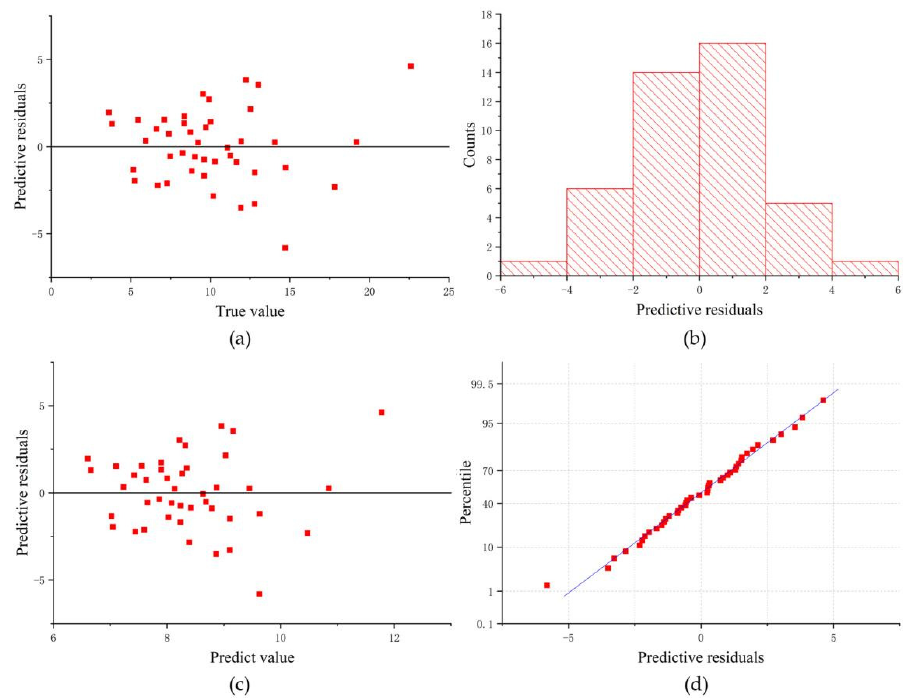
Figure 17. Coherent amplitude method with multilayer perceptron estimation of height residuals: ( a ) predicted residuals of true tree height; ( b ) the counts of predicted residuals; ( c ) predictive residuals of predicted value; ( d ) the percentile of predictive residuals.